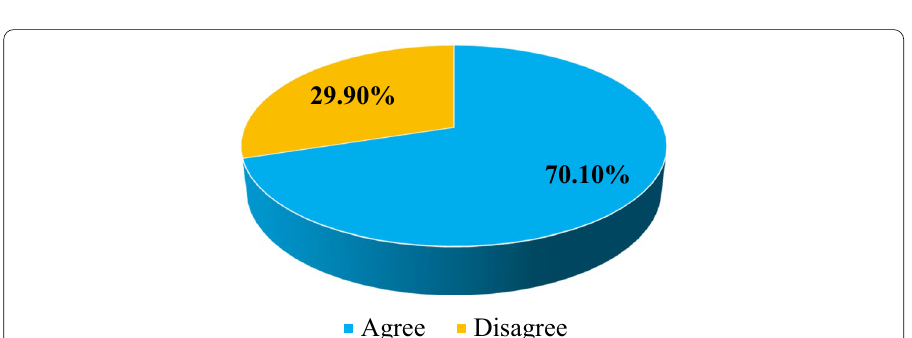
Fig. 23 Agreeing and disagreeing with that, social and non-for-profits project developing revenue generation arms, it harms their reputation